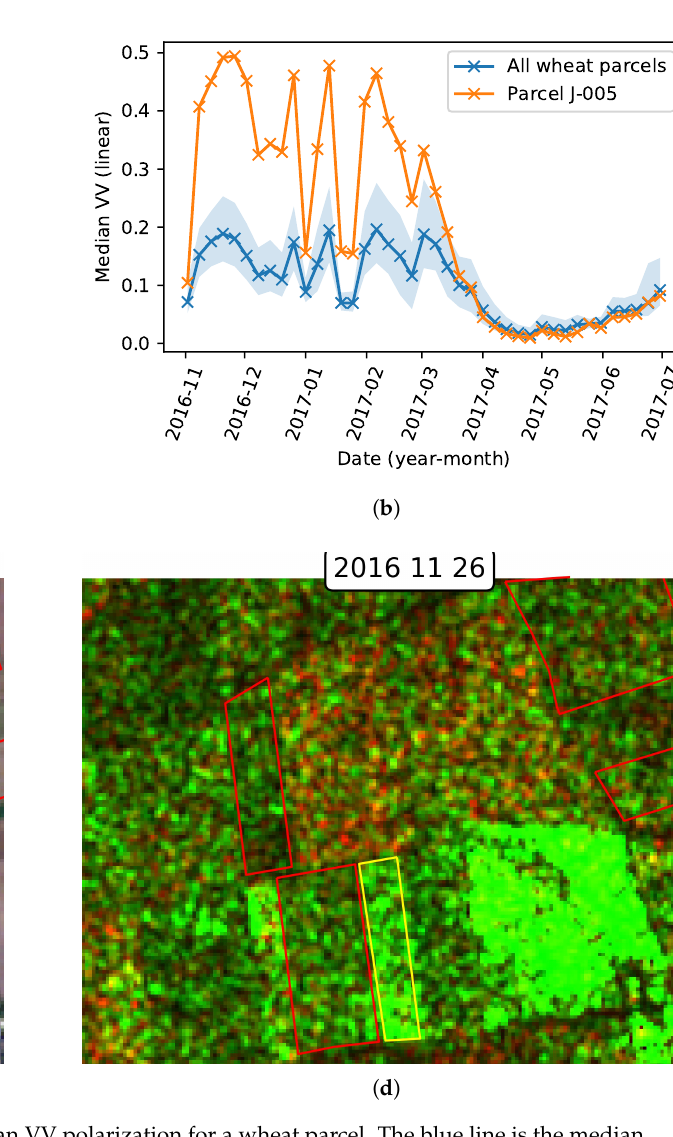
Figure 10. Time series of ( a ) median NDVI and ( b ) median VV polarization for a wheat parcel. The blue line is the median value of the whole dataset. The blue area is filled between the 10th and 90th percentiles. The orange line corresponds to a specific flashing-field parcel. Images acquired at the end of November: ( c ) true color S2 image (the yellow boundary corresponds to the analyzed parcel) and ( d ) S1 composite image (Green = VV, Red =